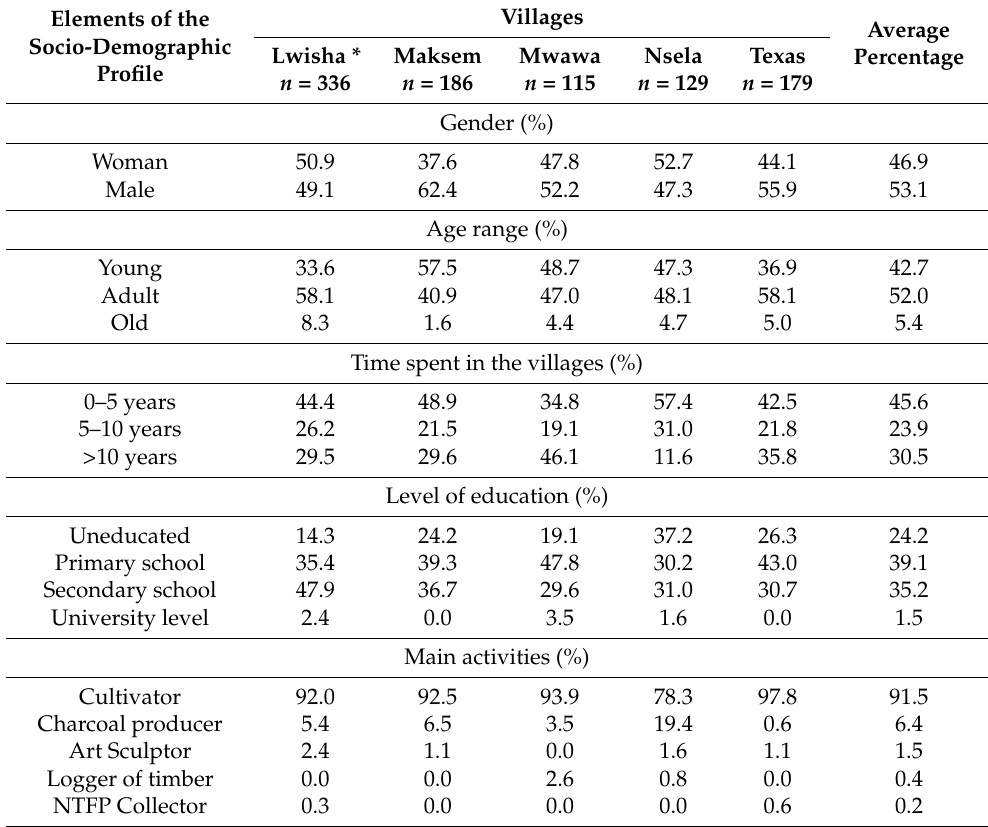
Table 2. Socio-demographic characteristics of heads of households in different villages in the rural area of